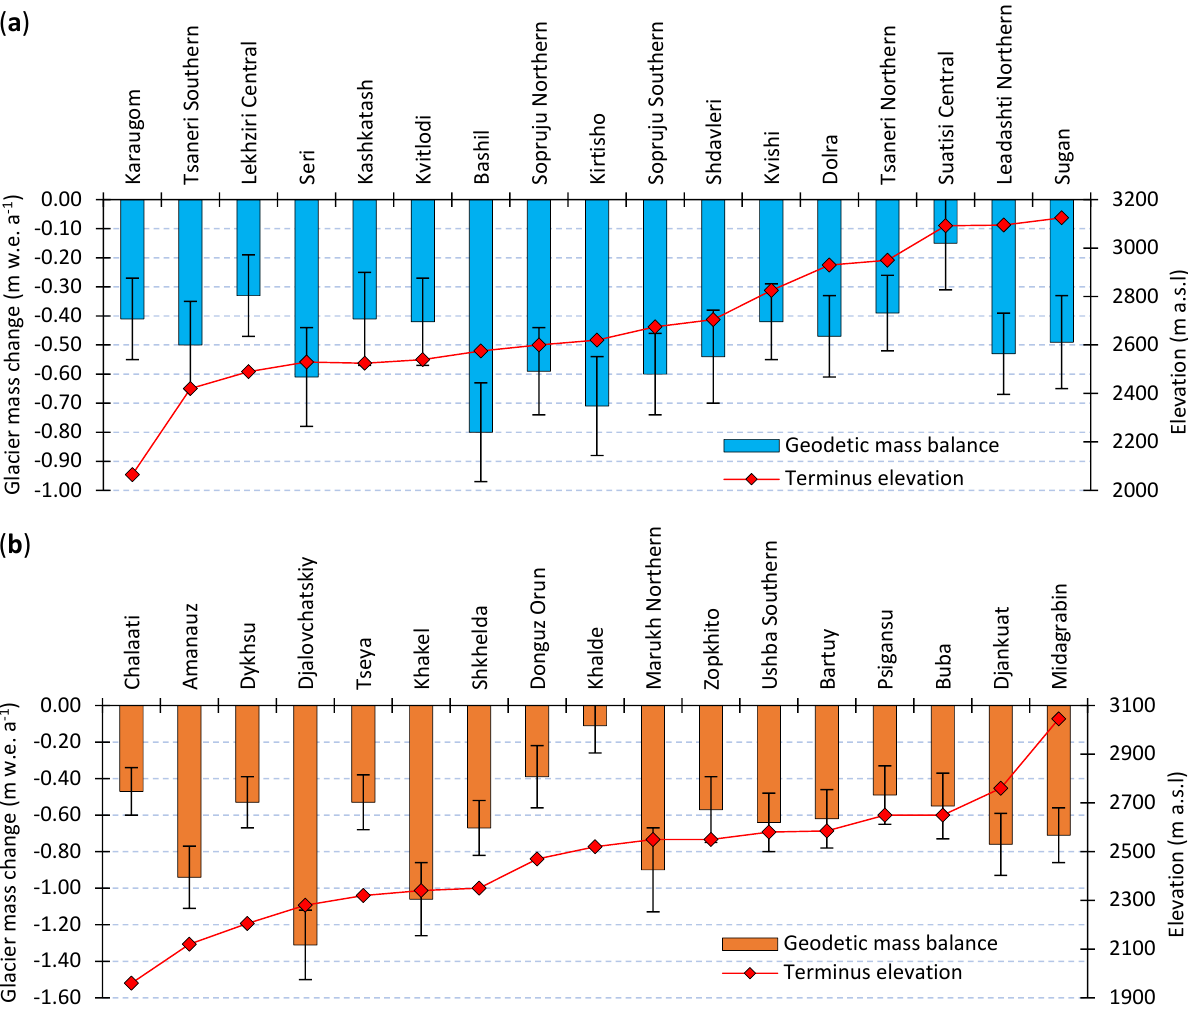
Figure 7. Changes in mean annual mass balance (m w.e. a − 1 ) for debris-free ( a ) and debris-covered ( b ) glaciers vs. terminus elevation in 2000–2019. Red dots indicate the terminus elevation of each glacier. Vertical stems show an uncertainty estimation of the mean values.